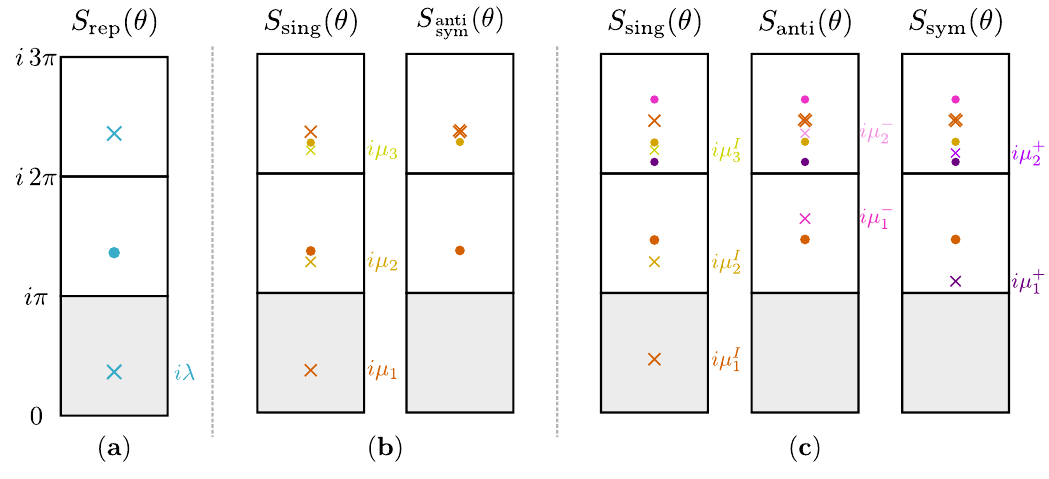
Figure 10 . Di(cid:11)erent types of analytic structures appearing in the (cid:18) plane. ( a ) Simple structure given by a single ratio of gamma functions F (cid:21) + (cid:25) ( (cid:18) ). ( b ) The simplest fractal structure with an in(cid:12)nite set of parameters (cid:22) i labelling the new towers of poles and zeros appearing in higher strips; this is the type of structure present in the green line of (cid:12)gure 2 described in appendix C.3. ( c ) The general fractal structure with three (in(cid:12)nite) sets of parameters ( (cid:22) I the representation (sing, anti, sym) on which the (cid:12)rst (i.e. closest to the physical strip) zero/pole